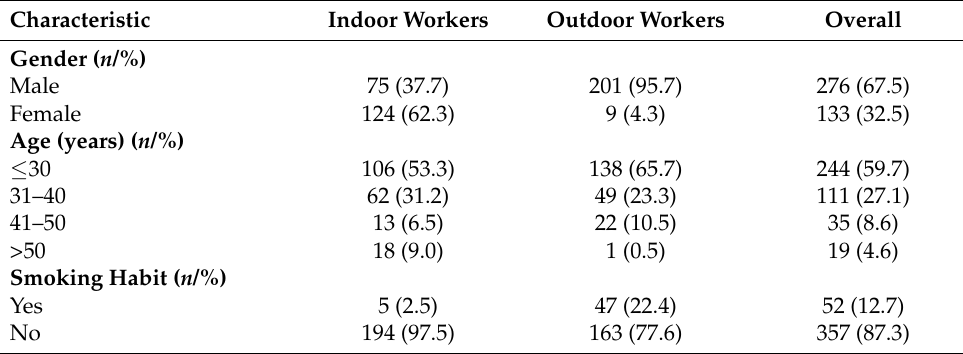
Table 1. Characteristics of Participants.